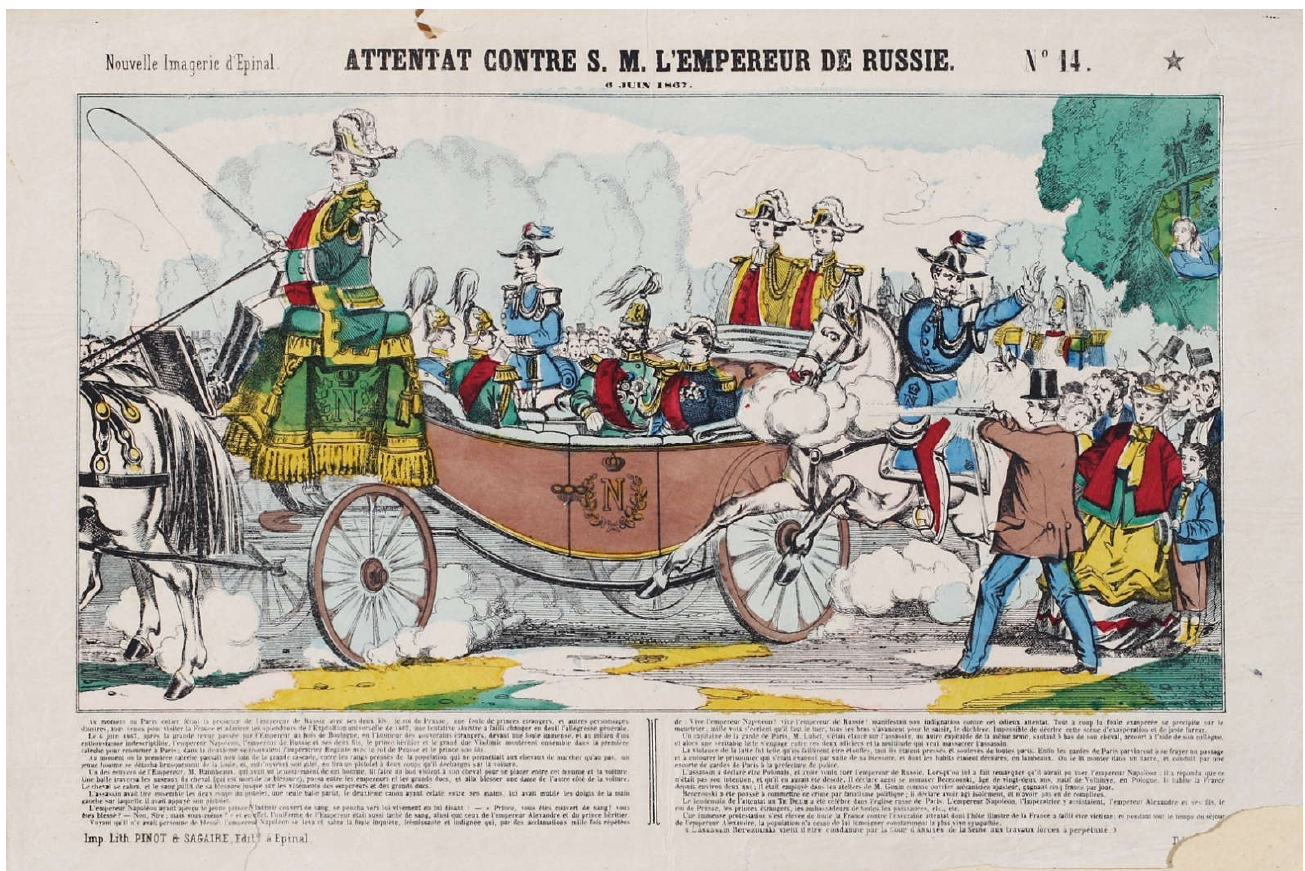
Figure 1. The 25 May 1867 assassination attempt on the life of Emperor Alexander II ( Nouvelle Imaqerie d'Epinal , issue 14, 6 June 1867).